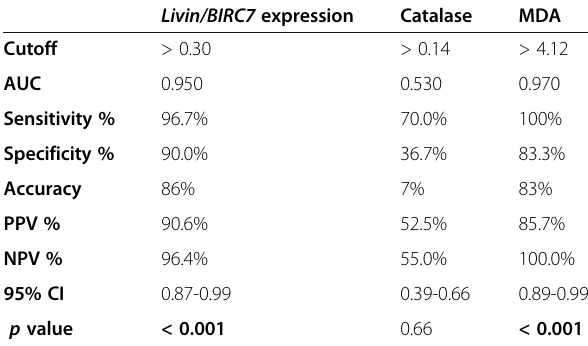
Table 5 Diagnostic performance of Livin/BIRC7 expression, catalase, and malondialdehyde (MDA) for prediction